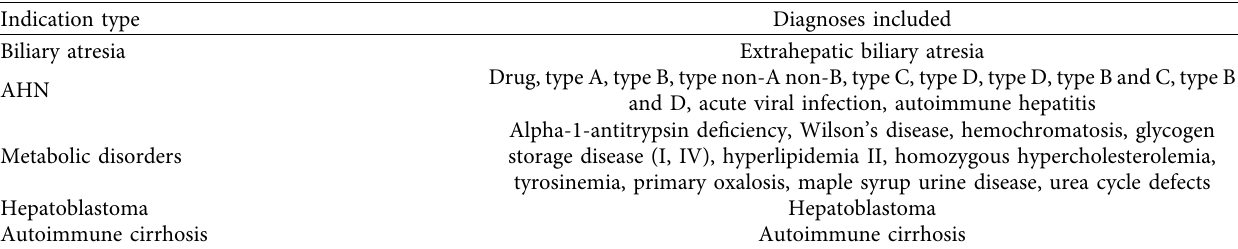
Table 1: Transplant